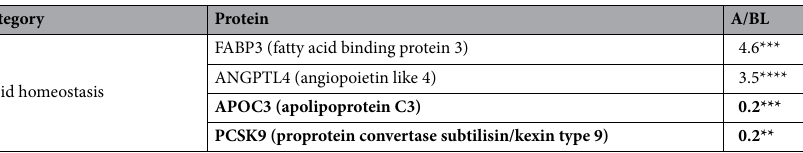
Table 1. Directional secretion of RPE effector proteins. A/BL = apical to basolateral ratio; proteins are listed from highest to lowest A/BL within each category. Due to size constraints, only proteins with at least threefold difference between apical and basolateral are shown. Bold highlights proteins with more basolateral than apical secretion. P-values were calculated with a two-tailed student’s T-test with a Benjamin-Hochberg adjustment. P-value < 0.05 (*), < 0.01 (**), < 0.001 (***), < 0.0001 (****), or < 0.00001 (*****).